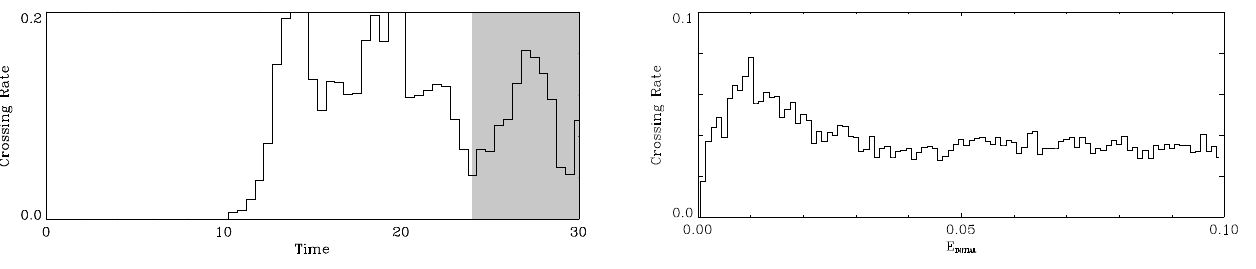
Fig. 3. Number of escaping particles depending on normalized time.